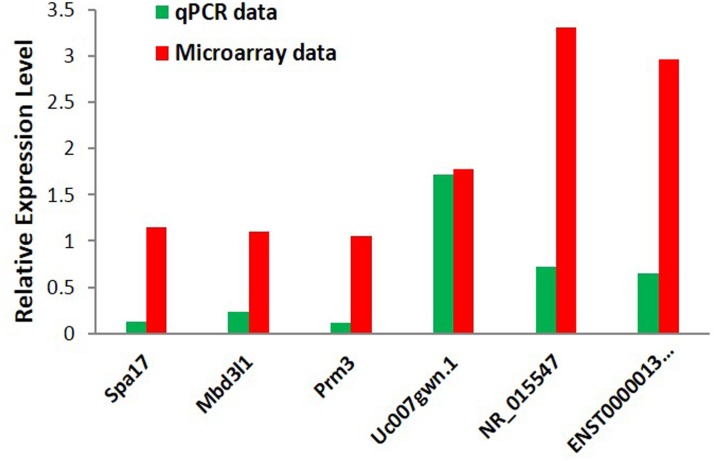
Microarray and quantitative PCR.Microarray and quantitative PCR for lncRNAs (Uc007gwn.1, NR_015547, ENSMUST00000134455) and mRNAs (Spa17, Mbd311, prm3). The quantitative PCR results were consistent with the microarray data.